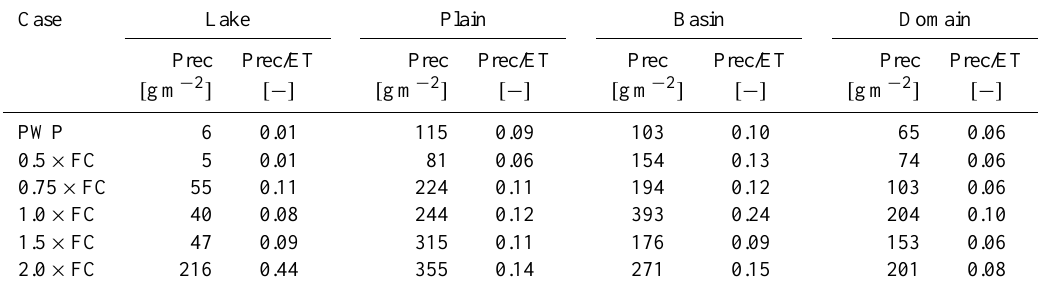
Table 2. Total simulated deposited precipitation (Prec, [gm − 2 ]) and normalised by evapotranspiration (Prec/ET [–]) for cases PWP, 0.5 × FC, text and the total domain. The area definitions are the same as those used in Fig. 7.